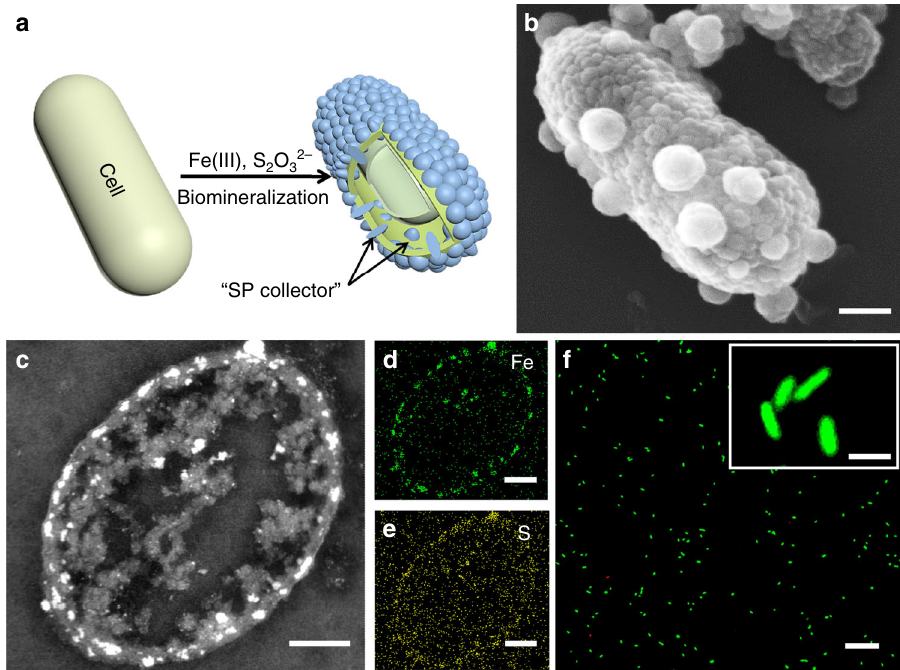
Fig. 3 Assembly of the SP collector on an SW cell. a Schematic illustration of the SP collector assembly. b SEM image of an SW@SP cell. c HAADF-STEM image of a sliced SW@SP cell. d , e EDS mapping of Fe or S element for a sliced SW@SP cell of. f Fluorescence microscopy image of SW@SP cells stained with a LIVE/DEAD assay kit. Green fl uorescence indicates living cells, red fl uorescence indicates dead cells. Scale bars: b , e 200 nm; f 20 μ m; inset of f 2 μ m. The inset of f shows an enlarged view of stained